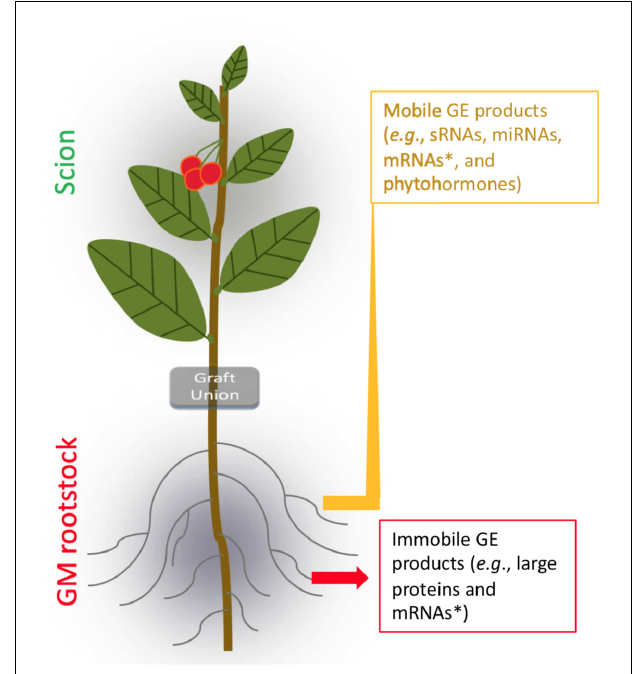
FIGURE 4 | Transgrafting of F&N crops. GE, genetic engineering; SRNAs, small RNAs; miRNAs, micro RNAs. ∗ Selective targeting movement (Luo et al.,